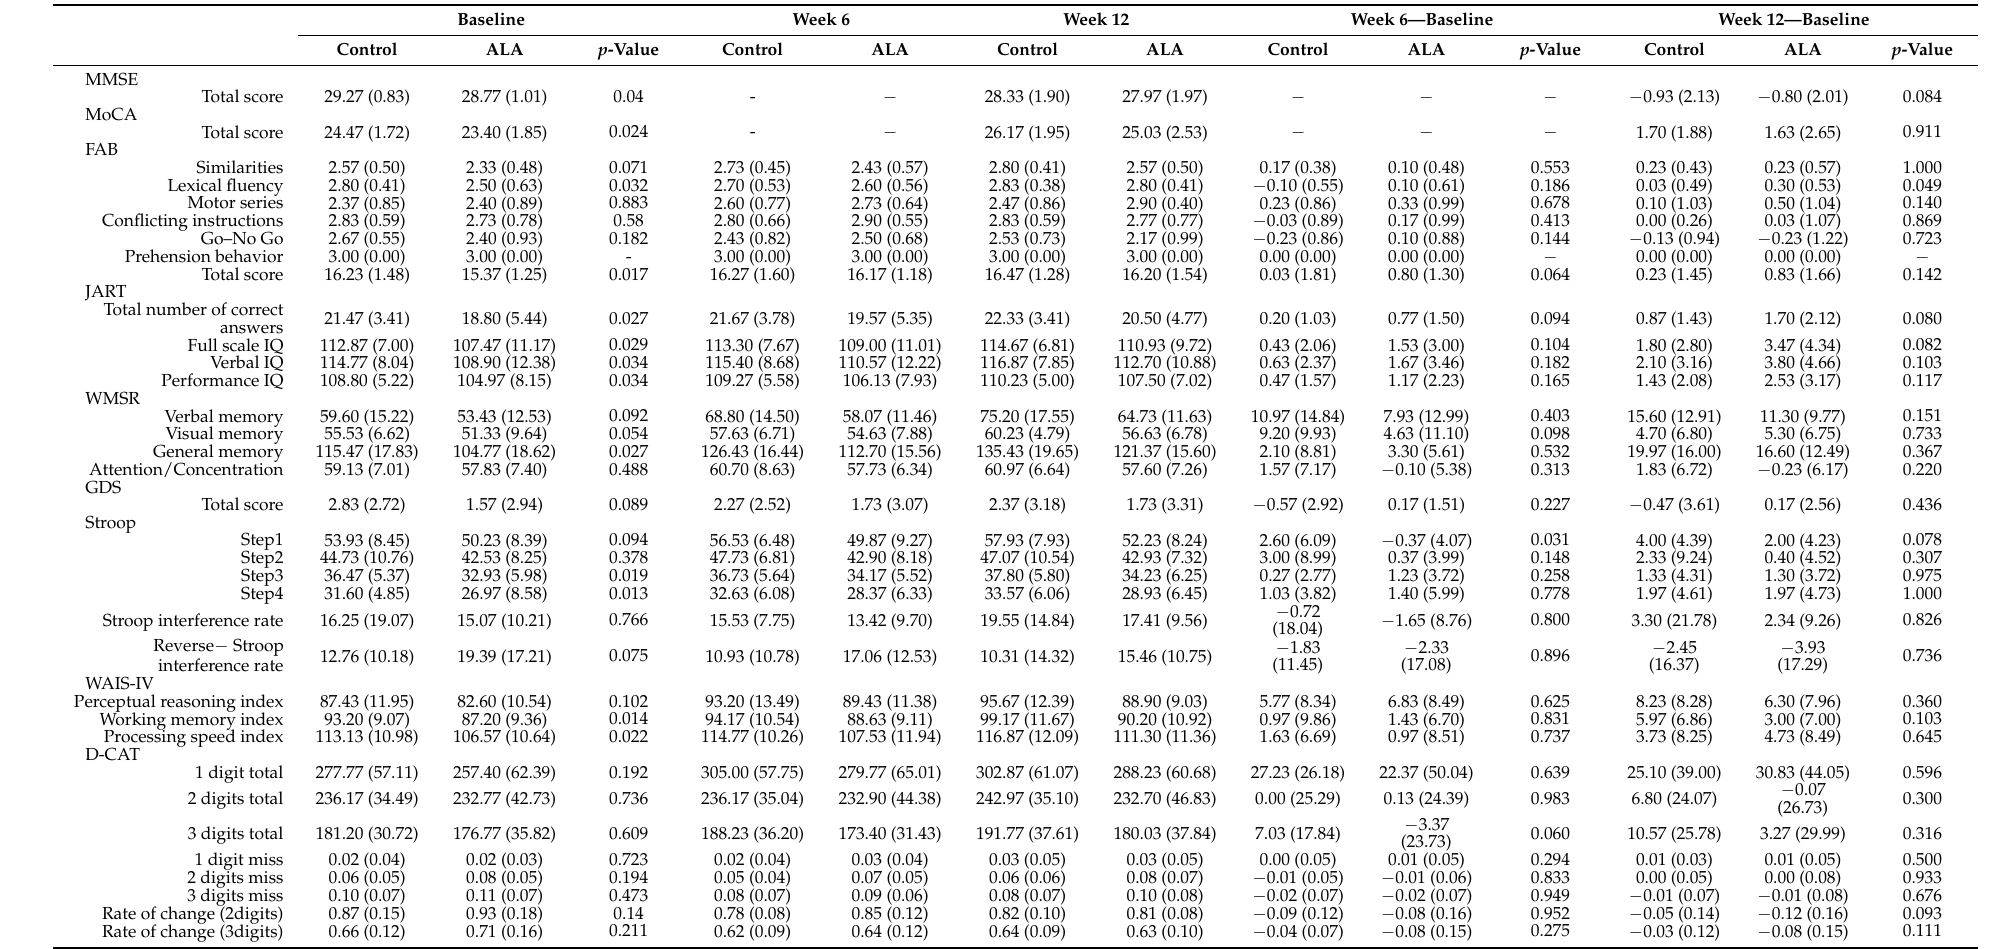
Table 3. The scores of changes in cognitive